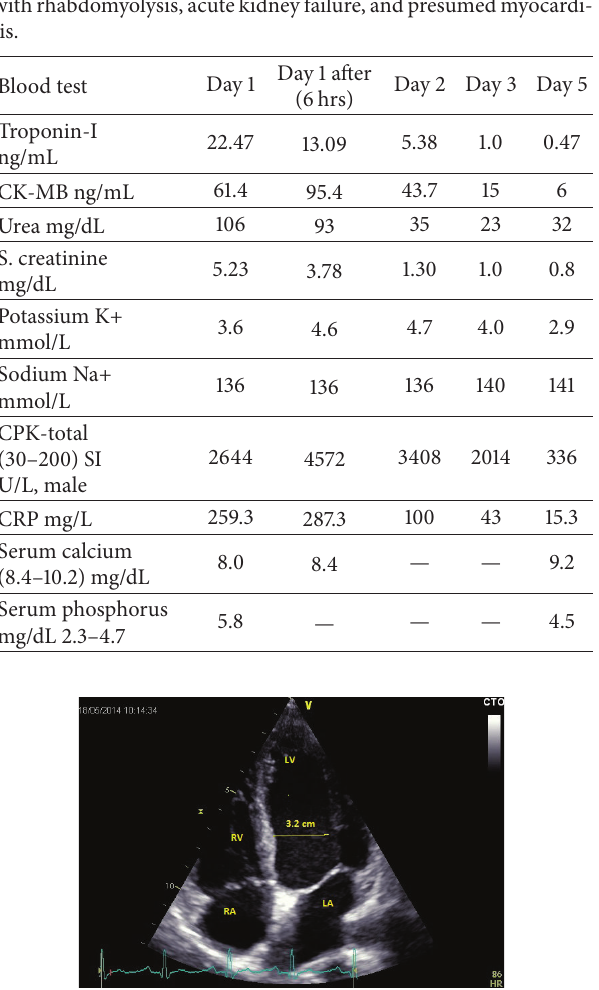
Table 1: The values of renal parameters, creatinine phosphokinase (CPK),C-reactiveprotein(CRP),andcardiacmarkersduringthein- hospital stay of a patient with salmonella gastroenteritis complicated with rhabdomyolysis, acute kidney failure, and presumed myocardi-